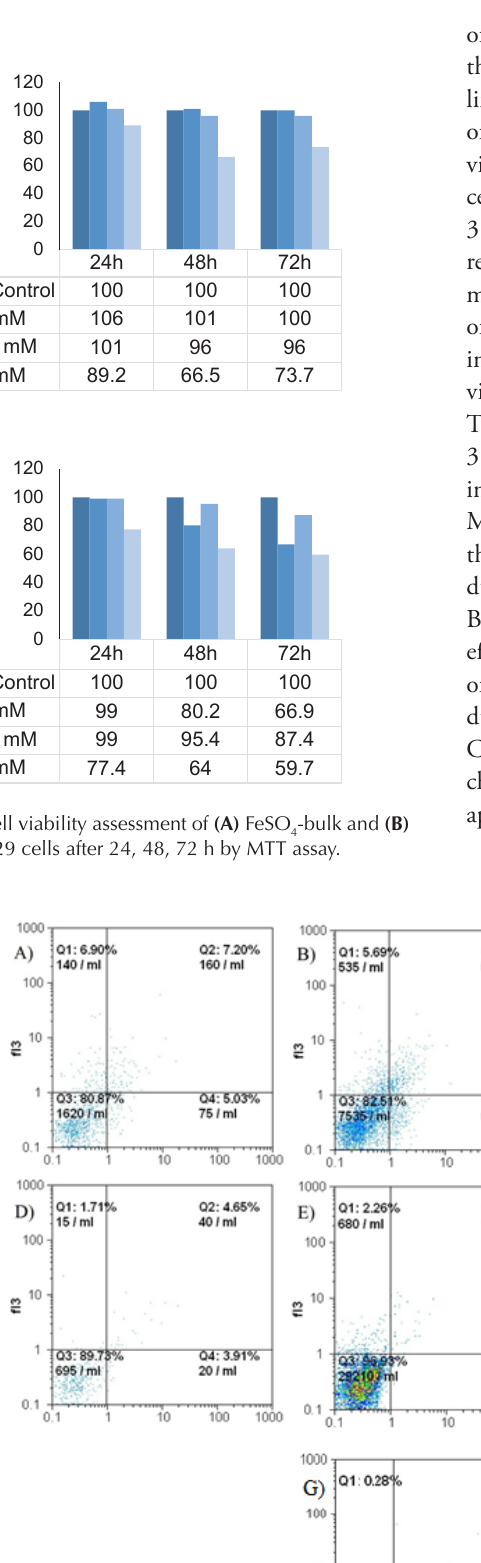
particles after 24 h treatment with: (A, B, C: FeSO4-bulk, 6.25, 3.125, 4